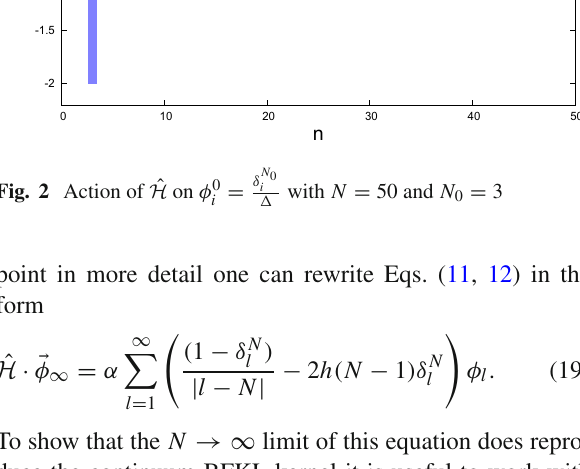
Fig. 3 χ N (γ) coincides with the BFKL eigenvalue χ(γ) at N → ∞